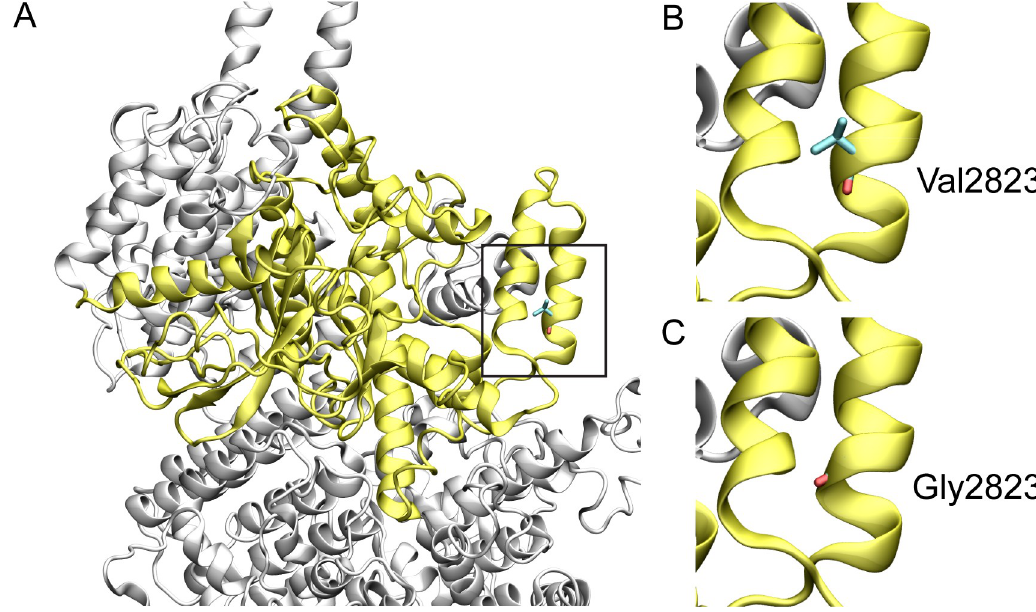
Fig 1. Structural model of wild-type and variant ATM protein. The ATM protein structure is shown in white cartoon representation and the kinase domain is shown in yellow. Amino acids are shown in stick representation. The black boxed region is enlarged in the subsequent two images. ( A ) Structure of the conserved kinase domain of ATM, ( B ) wild type Val2823, and ( C ) variant Gly2823.